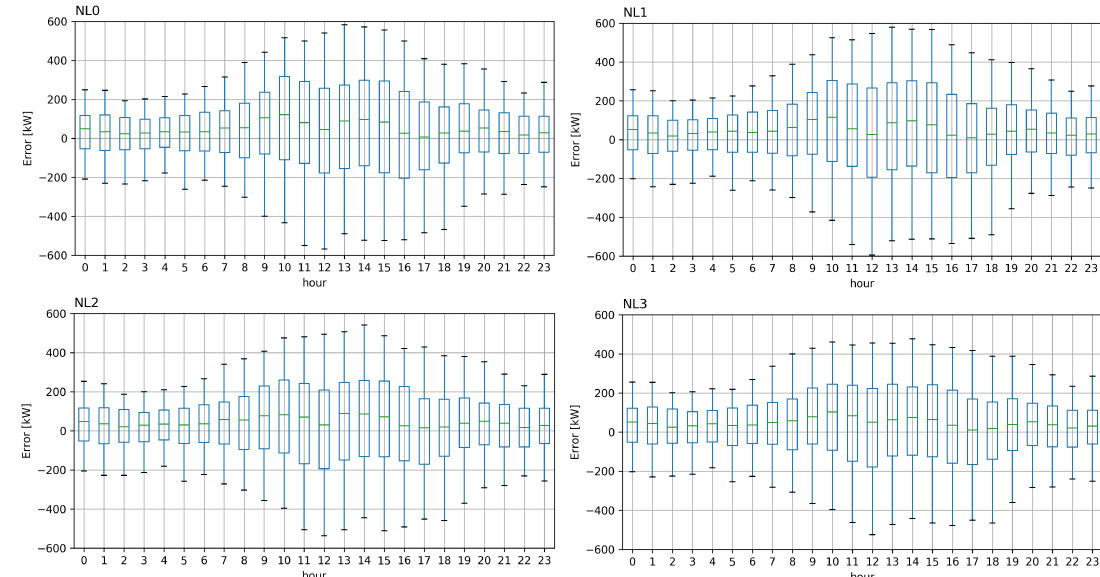
Figure 5. Boxplot of the net load forecast error as a function of the hour of the day. The box represents the interquartile range, the line in the box is the median, and the whiskers are set at the 5 and 95 percentile of the data range. The uncertainty follows the same daily pattern of the PV generation. The improvement in the forecast accuracy obtained with the model NL3 is